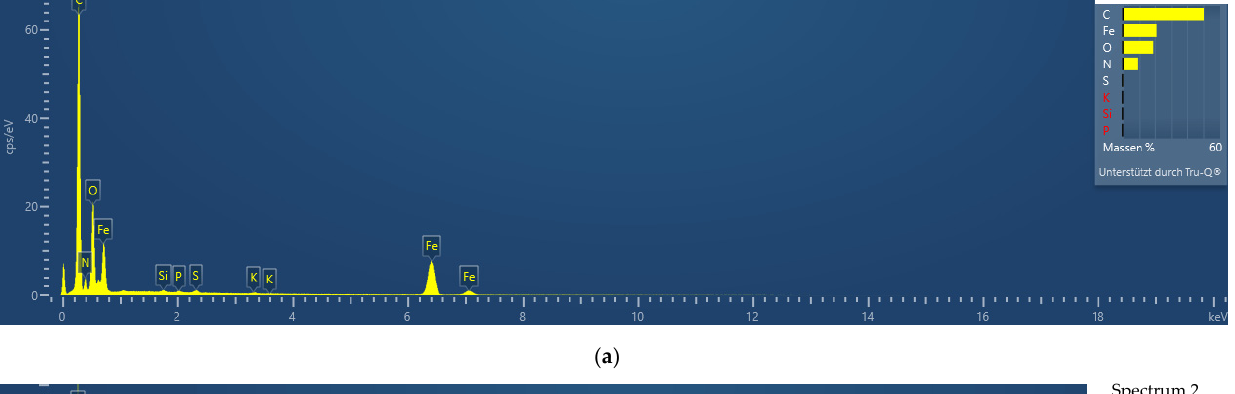
Figure 8. SEM image of PAN/magnetite nanofiber mat ( a ) spot on a bead (Spectrum 1); and ( b ) spot on a nanofiber (Spectrum 2). The scale bar indicate 2.5 μ m.